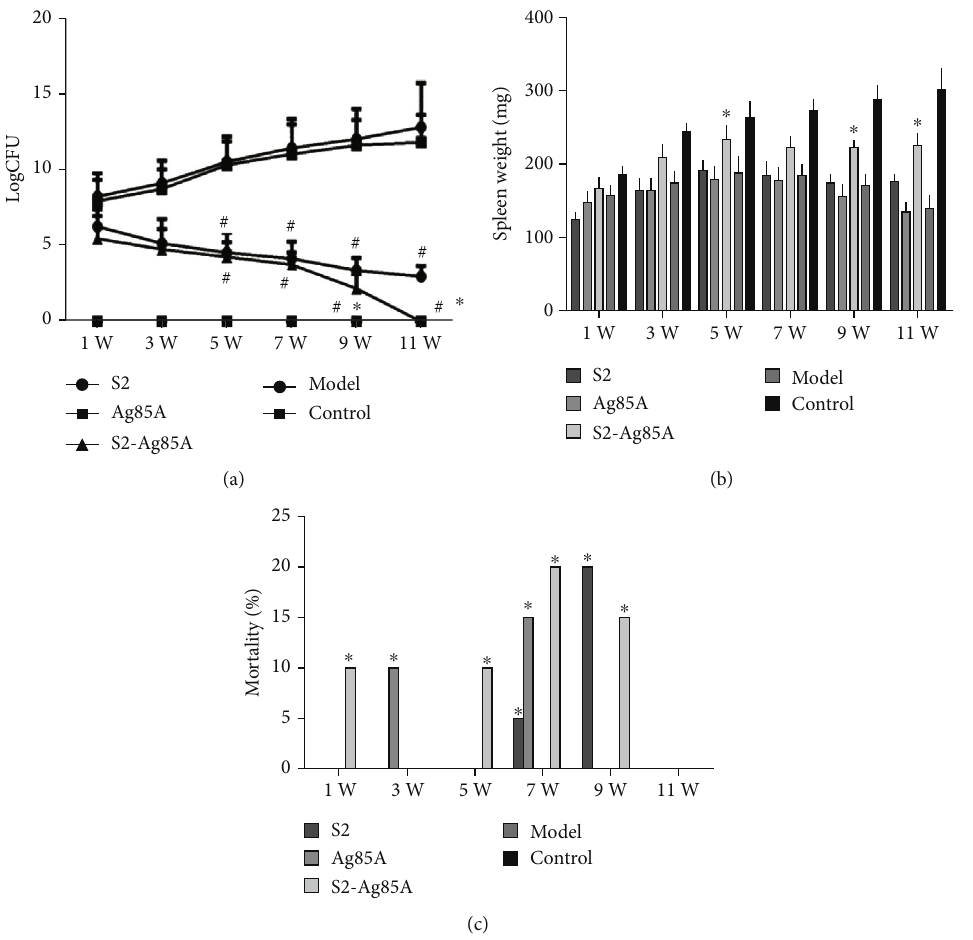
Figure 6: The S2-Ag85A oral vaccine provides better protection against Brucella infection in mice. (a) The bacterial content in the spleen of rats in each group was roughly the same one week after infection, and the bacterial content showed a signi fi cantly lower level in the spleen of mice in the S2 and S2-Ag85A groups than that in the model group at the 5th week ( P < 0 : 05 ). (b) At each of 1-5 weeks, the weight of the spleen of mice in the group showed an upward trend. After 5 weeks, the spleen began to atrophy, and the weight of the spleen began to decrease. The mice in the 5, 9, and 11 W S2-Ag85A groups showed a signi fi cantly elevated weight of spleen than that in the model group ( P value < 0.05). (c) From the fi rst week, in the beginning, the S2 group, Ag85A group, and model group showed di ff erent degrees of death, and these group showed a signi fi cantly elevated death rate than that in the S2-Ag85A group ( P value <